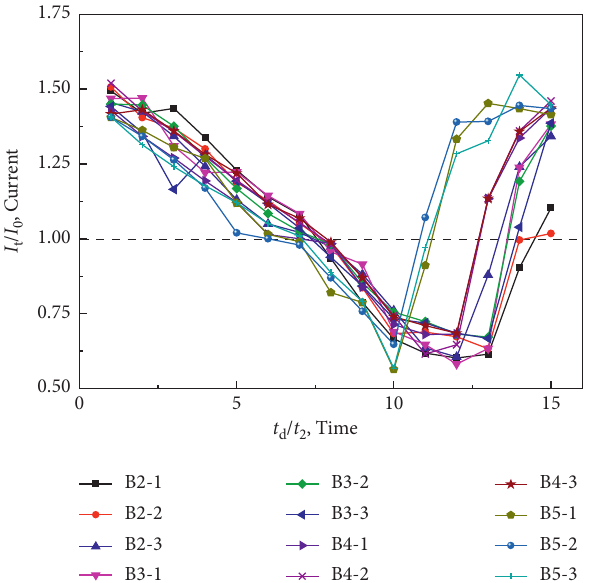
Figure 5: Plots of the current during the test as a function of time ( t